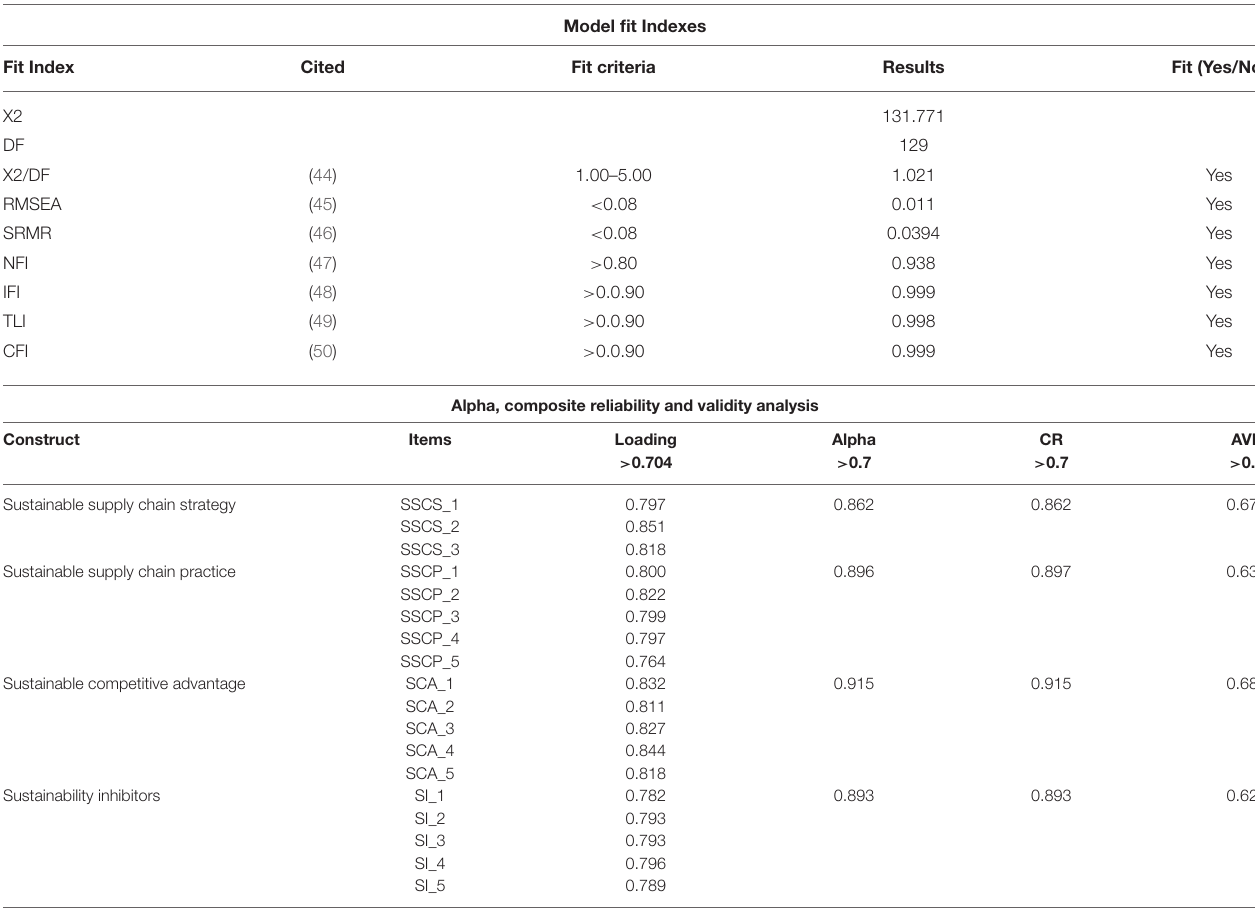
TABLE 2 | Model fit and reliability and validity